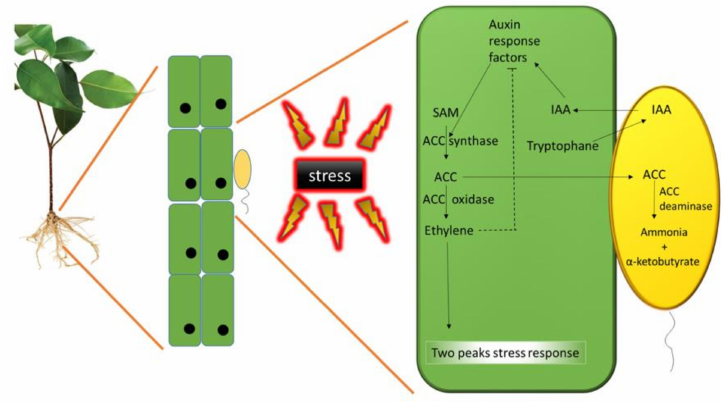
Figure 2. Bacterial Indole- 3-Acetic Acid (IAA) and 1-Amino-Cyclopropane-1-Carboxylic Acid (ACC) deaminase interplay: Plant ethylene is synthesized from S-adenosyl-L-methionine (SAM) and ACC through the enzymes SAM synthetase and ACC synthase, respectively. Then, ACC is converted to ethylene by ACC